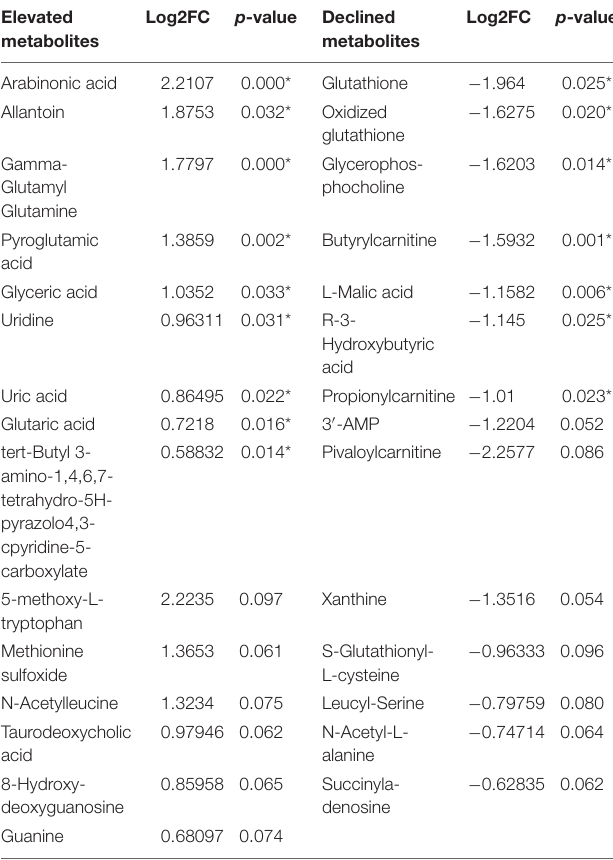
TABLE 2 | Differential metabolites of basal and luminal subtype (basal vs. luminal). Elevated